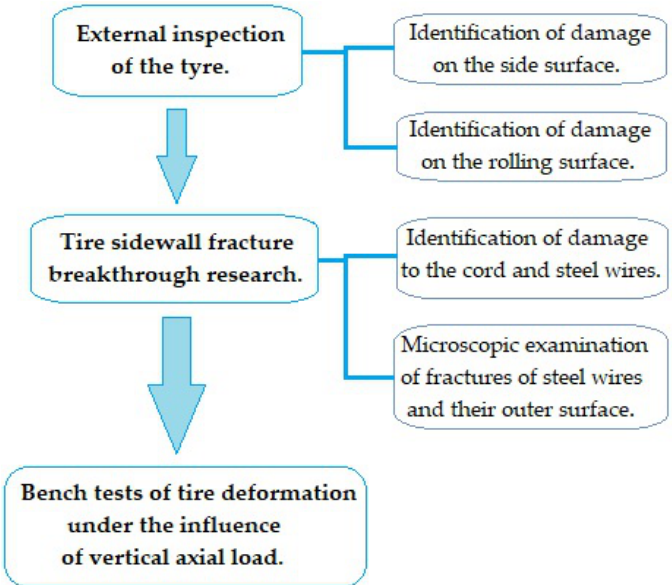
Figure 3. Block diagram of selected analysis phases.